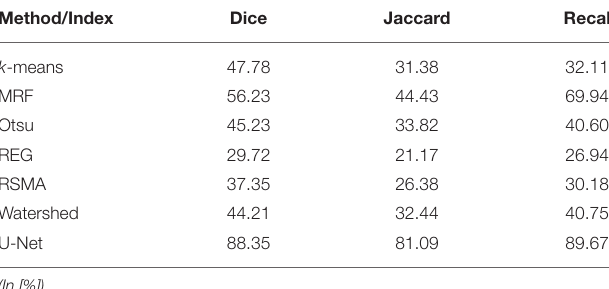
TABLE 8 | Evaluation of feature extraction methods using EMDS-6 dataset.